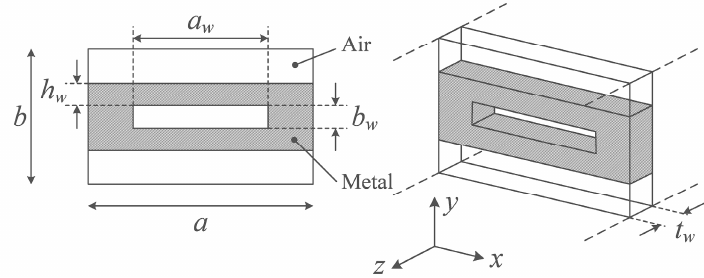
Figure 2. Simplified multi-aperture iris with definition of dimensions.